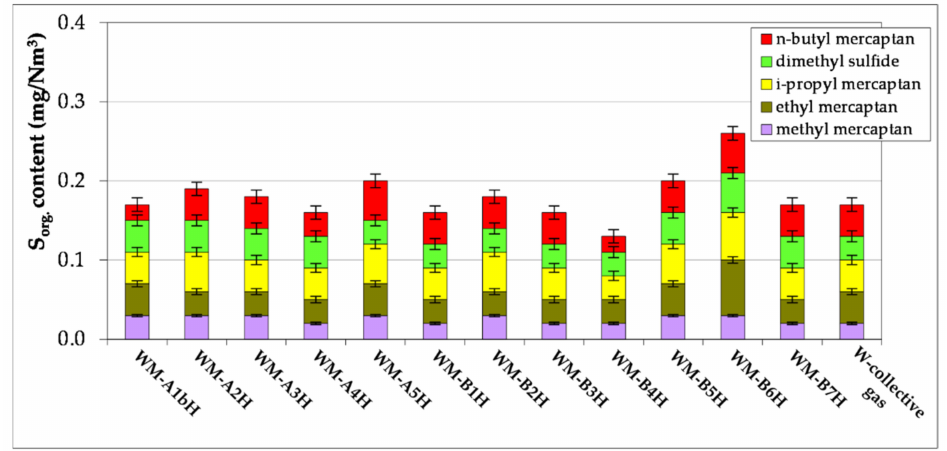
Figure 6. A comparison of the content of organic sulphur compounds in natural gas from individual horizontal wells in clusters A and B of the Wierzchowice Underground Gas Storage facility in the XXV exploitation cycle (III measurement series).